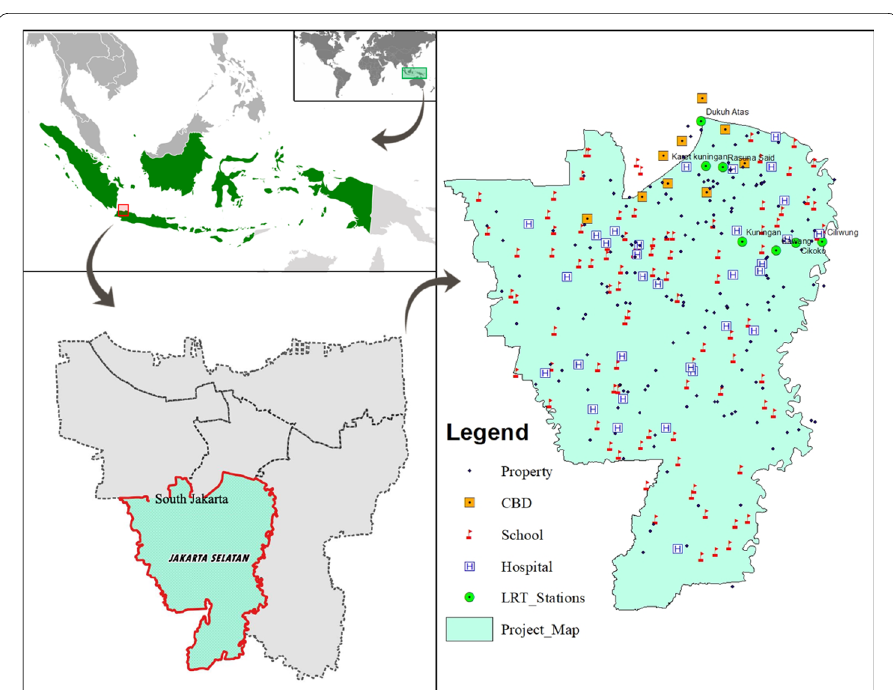
Fig. 3 Map of listings from data mining process in South